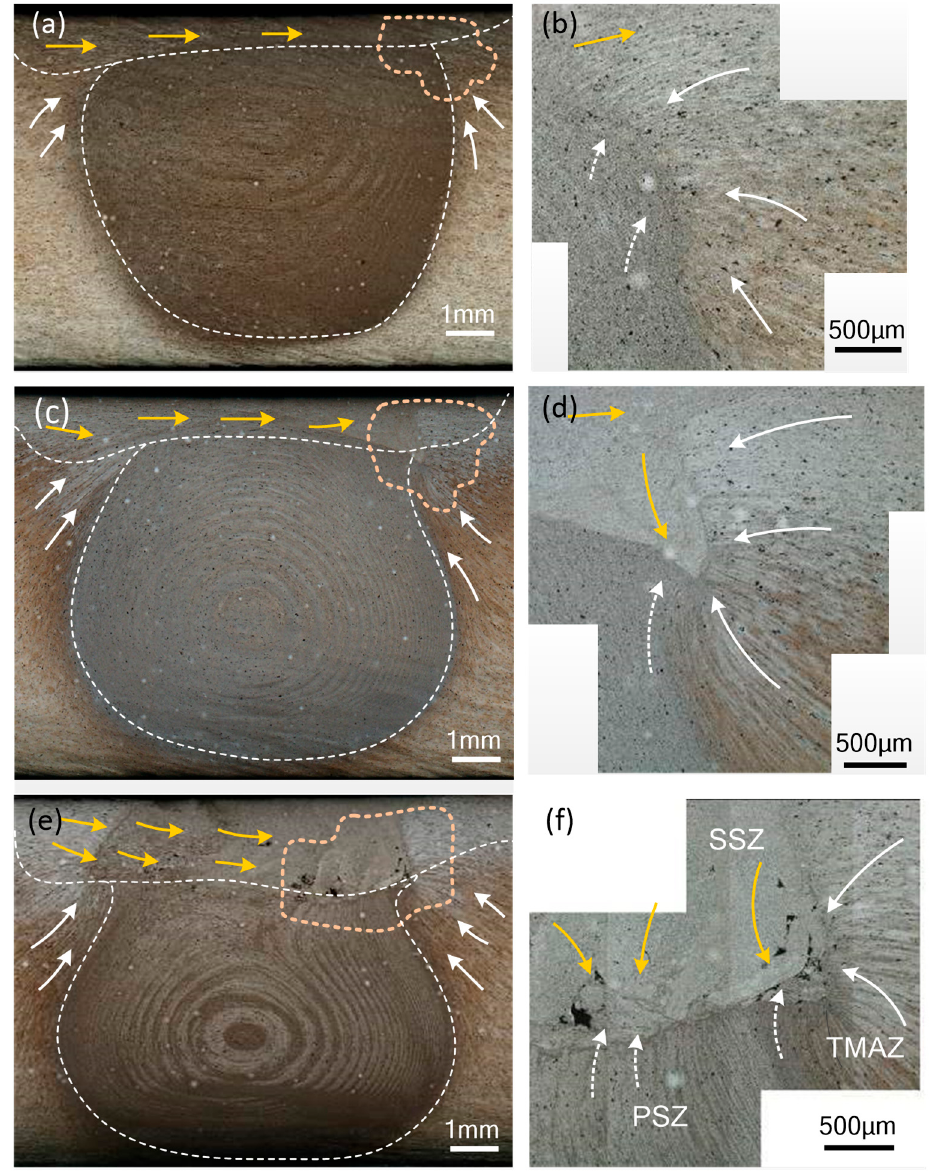
Figure 17. The joint cross section and material flow pattern at different rotating speeds. ( a ), ( c ) and ( e ) are the joint cross sections at 500 rpm, 900 rpm and 1300 rpm respectively; ( b ), ( d ) and ( f ) are material flow patterns corresponding to ( a ), ( c ) and ( e ).